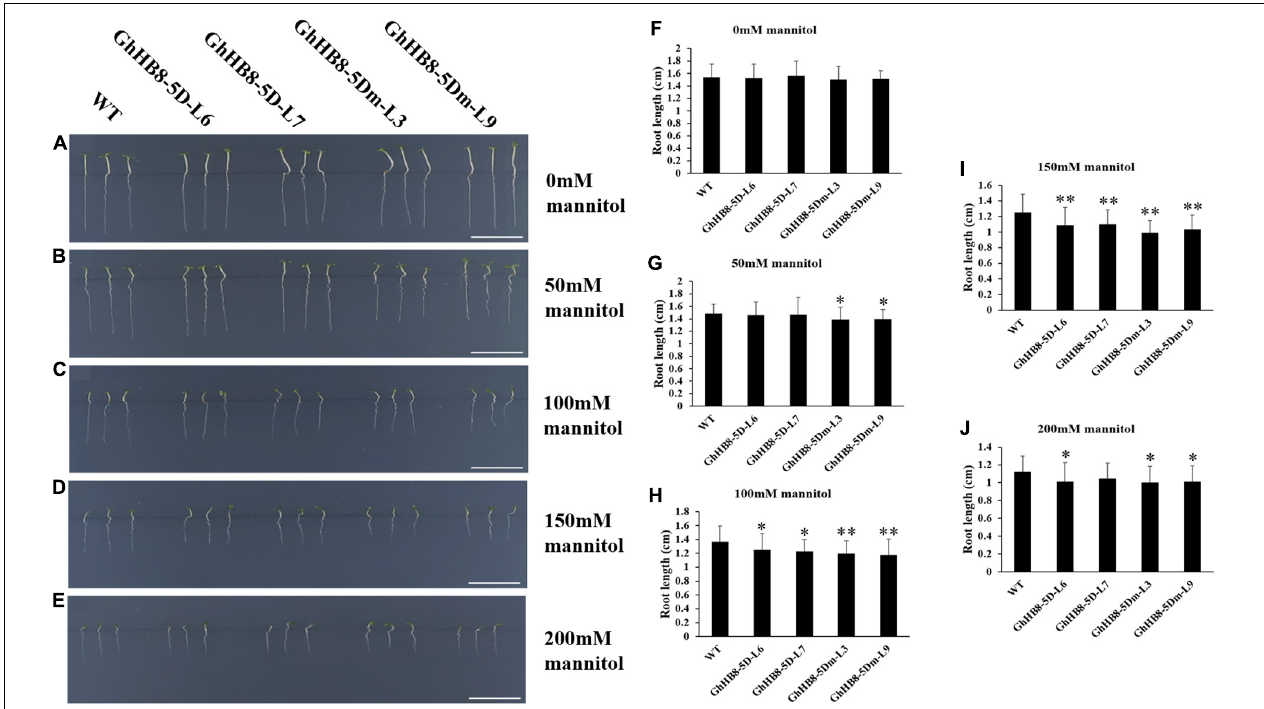
FIGURE 11 | Analysis of root length of wild type and transgenic lines overexpressing GhHB8-5D and GhHB8-5Dm under mannitol treatment. (A–E) The phenotype of wild type and transgenic seedlings under different concentrations of mannitol treatment for 7 days. Bars = 1 cm. (F–J) Statistical analysis of root length of wild type and transgenic seedlings under different concentrations of mannitol treatment for 7 days. Mean values and SD are shown from three biological replicates. Independent t -tests demonstrate that there are significant ( p < 0.05) or very significant ( p < 0.01) differences in root length between wild type and transgenic lines. *means significant differences ( p < 0.05); **means very significant differences ( p <